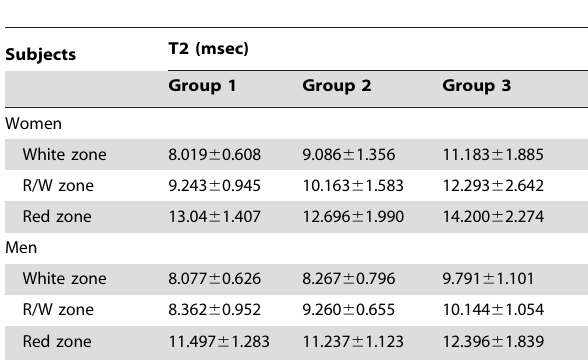
Table 3. Meniscal T2 measurements in three zones.